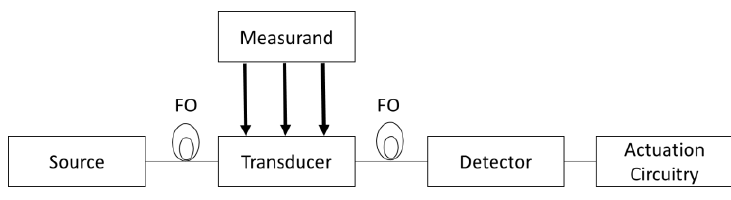
Figure 1. Fiber optic sensor simplified architecture.